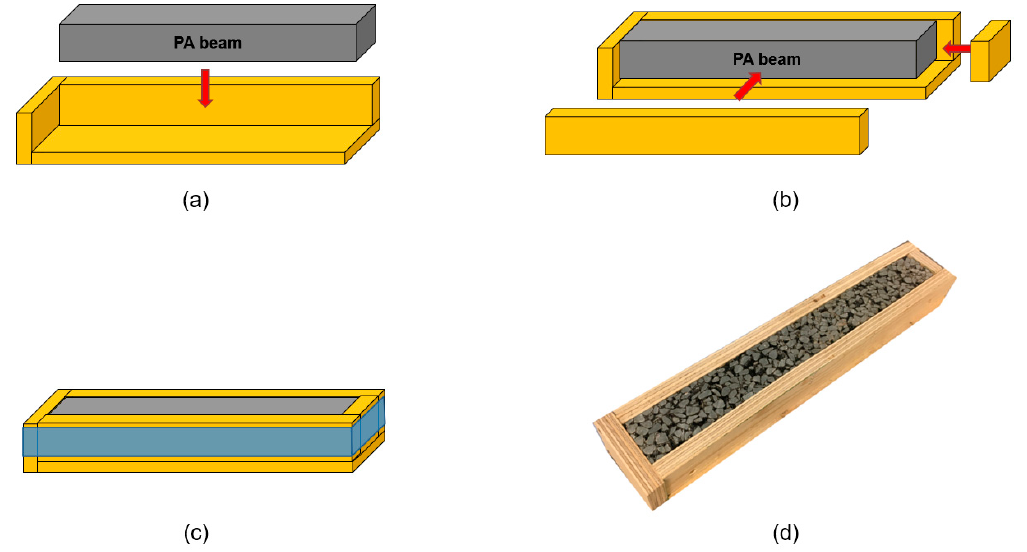
Figure 10. The adjustable wooden box for the confining of beam specimen: ( a ), ( b ) and ( c ) show the schematic confining process for a beam specimen, while ( d ) shows the image of a beam specimen confined in the wooden box.